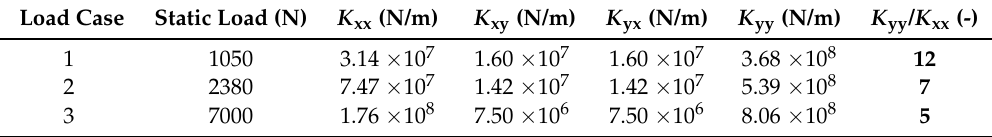
Table 3. Brief summary of the calculated bearing stiffness values for the different static load